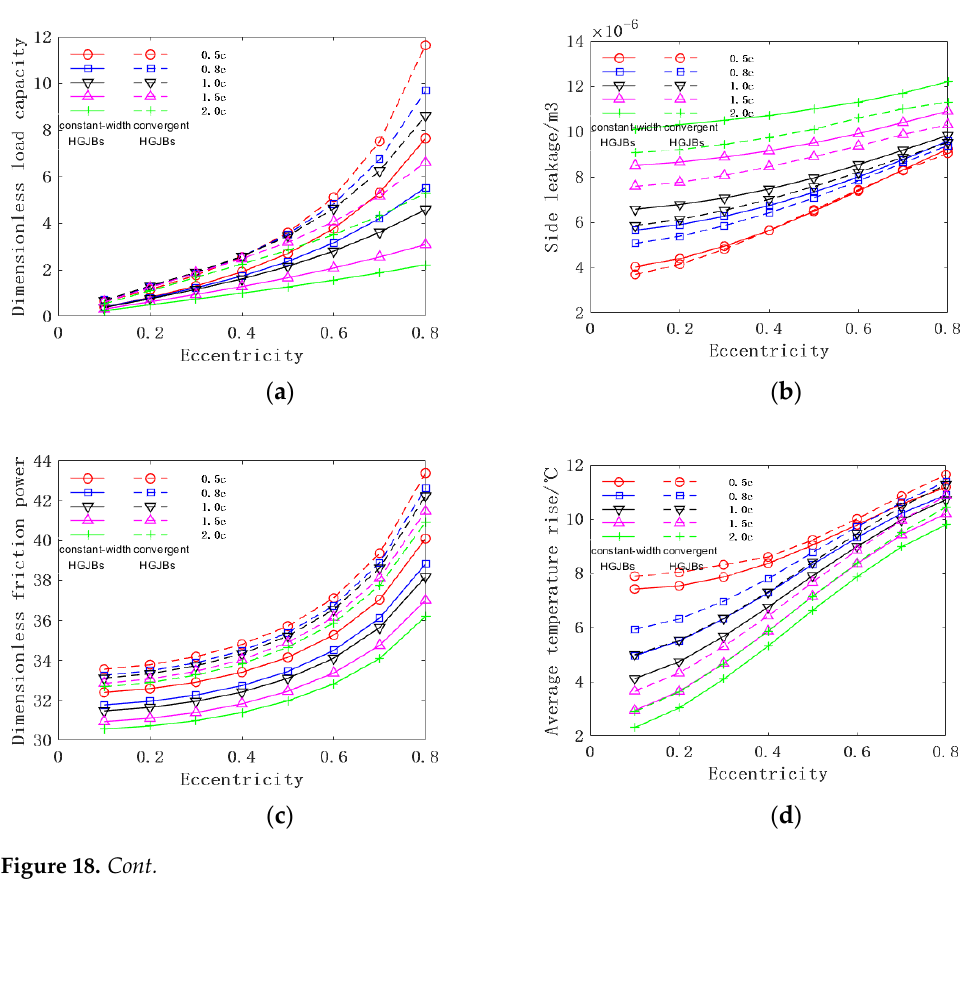
( f ) Figure 18. The influence of groove depth on the performance of HGJBs: ( a ) Dimensionless load capacity ( b ) Side leakage ( c ) Dimensionless friction power ( d ) Average temperature rise ( e ) Dimensionless principal stiffness ( f ) Dimensionless principal damping. Figure 18 shows that as the groove depth increases, the bearing load capacity shows a gradual decreasing trend; the side leakage increases, and the friction power decreases slowly with the increase of the groove depth. The temperature rise gradually decreases and stabilizes. When the groove depth is 0, the HGJBs becomes an ordinary journal bearing at the moment, so the bearing load capacity will reach the maximum. On the one hand, by increasing the groove depth, the existence of the groove will destroy the continuity of the bearing oil film pressure; on the other hand, as the groove depth increases, it will cause the generation of cavities, resulting in a decrease in the bearing load capacity. When the eccentricity is 0.5, the maximum bearing load capacity of the convergent HGJBs is 26.43% larger than the minimum bearing load capacity, and the